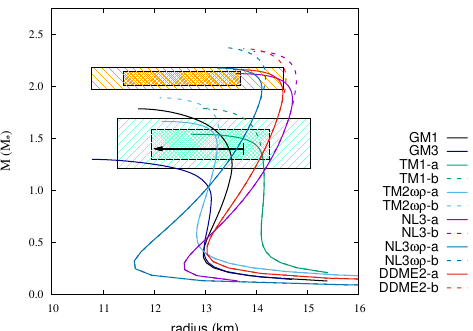
Figure 1. MR relations of 12 EoSs without magnetic fields. The unstable region in each EoS is not shown. The orange and light green dashed areas indicate pulsars PSR J0740+6620 and PSR J0030+0451 (68% (thick) and 90% (thin) credibility), respectively. The arrow indicates the upper limit of radius for 1.4 M (cid:12) from the gravitational wave event GW170817. The colored lines represent the following: black (solid line), GM1 EoS; green (solid line), TM1-a EoS; green (dashed line), TM1-b EoS; light blue (solid line), TM2 ωρ -a EoS; light blue (dashed line), TM2 ωρ -b EoS; purple (solid line), NL3-a EoS; purple (dashed line), NL3-b EoS; dark blue (solid line), NL3 ωρ -a EoS; dark blue (dashed line), NL3 ωρ -b EoS; red (solid line), DDME2-a EoS; red (dashed line), DDME2-b